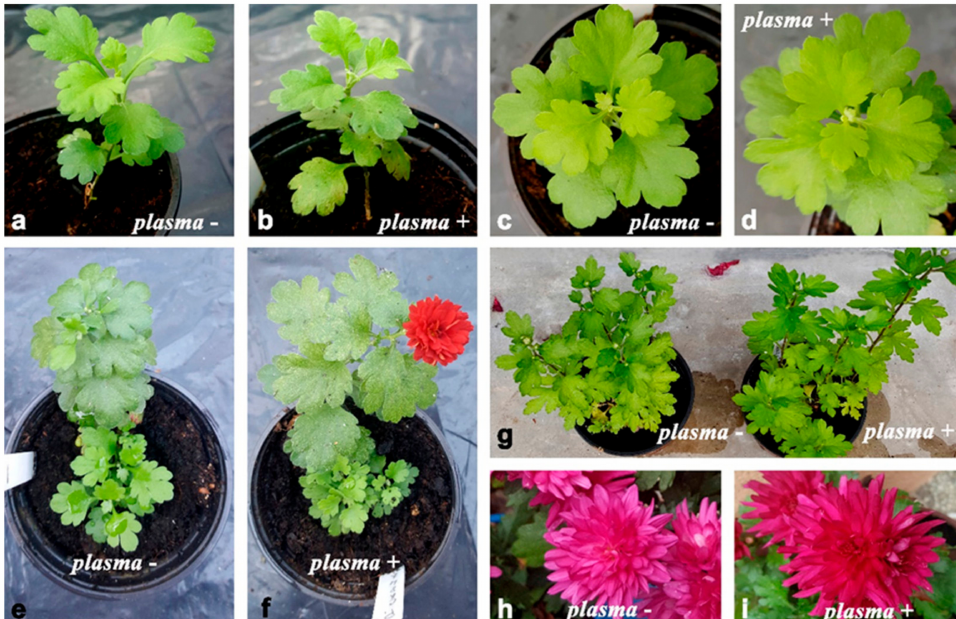
Figure 4. Chrysanthemum plantlets derived from synseeds during growth under greenhouse con- ditions (ex vitro). ( a – d ) Plants derived from untreated ( a , c ) and plasma-treated ( b , d ) synseeds of chrysanthemum cv. PC ( a , b ) and Q ( c , d ) three months after sowing; ( e , f ) Plantlets derived from untreated ( e ) and plasma-treated ( f ) synseeds of cv. PC six months after sowing; ( g – i ) untreated (left) and plasma-treated (right) chrysanthemum plants twelve months after sowing, during next flowering season, cv. BL; ( h , i ) flowering of chrysanthemum plants derived from untreated ( h ) and plasma-treated synseeds ( i ), cv.